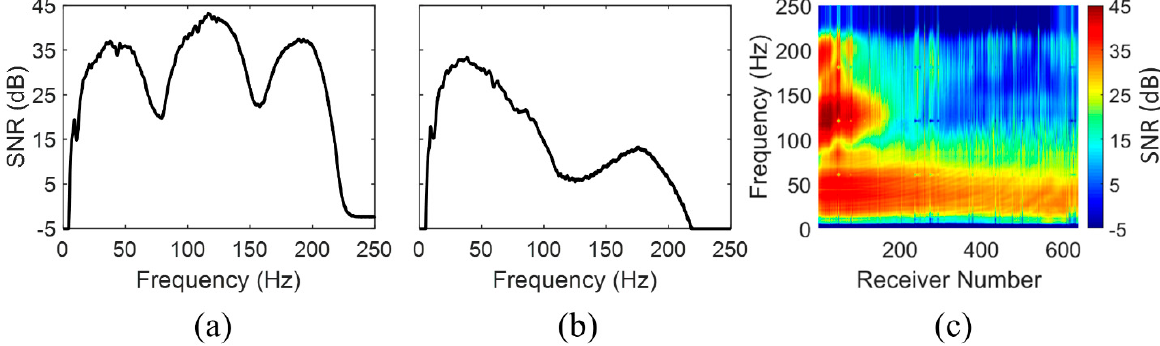
Figure 4. Signal-to-noise ratio (SNR) from (15) for the closest receiver ( a ) and halfway along the receiving array ( b ) for 829 signal pulses. SNR, plotted against both receiver number and frequency, is shown in panel ( c ). The dips in SNR, particularly for the nearest receiver, occur at the frequencies predicted for destructive interference of upward- and downward-propagating sounds at the depth of the receiver array.